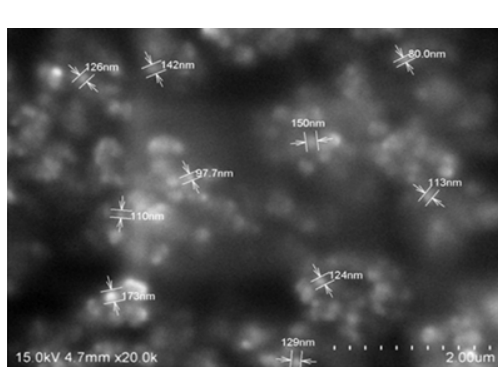
Fig. 7. SEM image of Psidium guajava - Chloroform silver nanoparticles